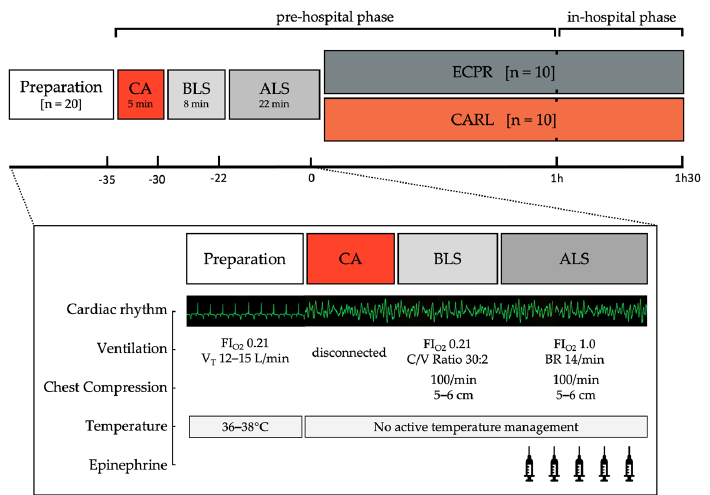
Figure 1. Schematic presentation of the experimental protocol. CA Cardiac arrest, BLS Basic life support, ALS Advanced life support, FiO 2 Fraction of inspired oxygen, V T Tidal volume, C/V Chest compression to ventilation ratio, BR Breathing